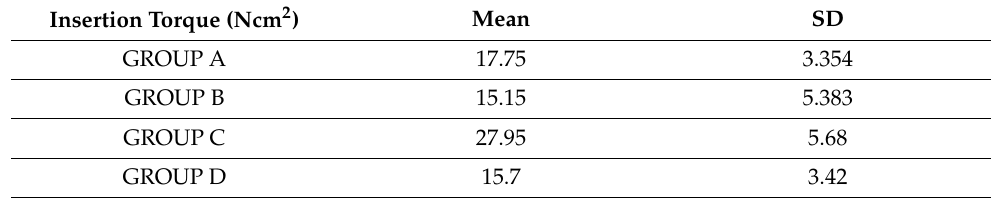
Table 1. Insertion torque means of the study groups.